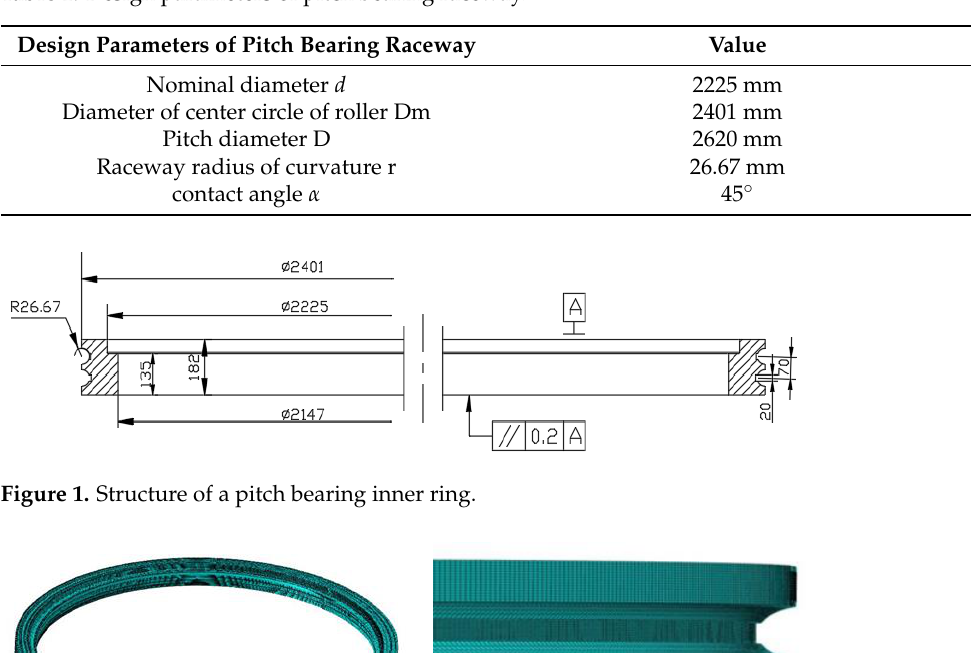
Table 1. Design parameters of pitch bearing raceway.